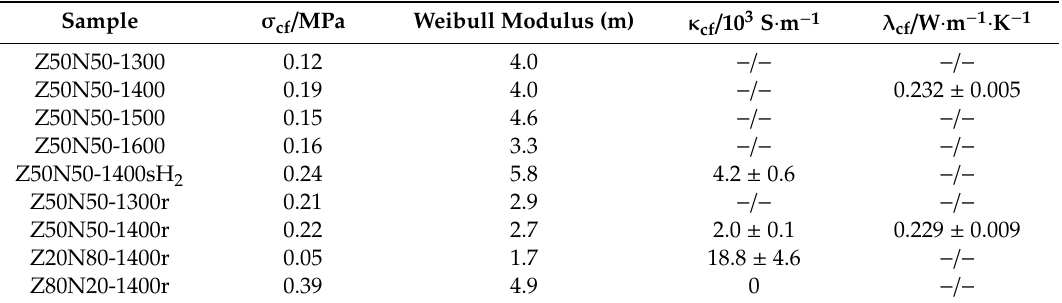
Table 2. Compressive strength σ cf (Weibull average of 10 specimens), electric conductivity κ el and thermal conductivity λ cf of NiO–YSZ and Ni–YSZ composite